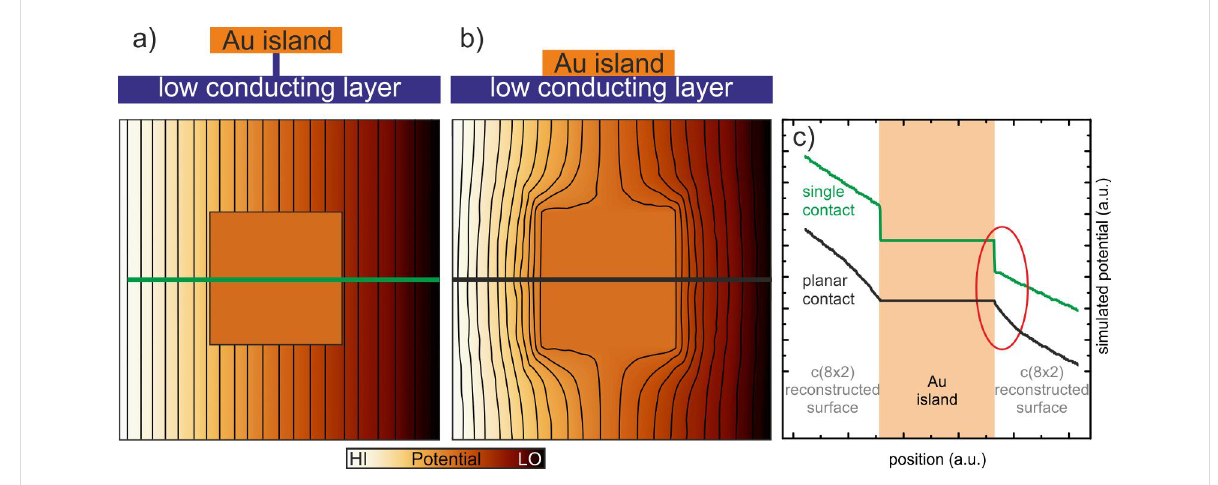
Figure 6: a) Finite elements simulation for the potential if one single path connects a highly conductive cluster to a low conducting substrate while the borders of the cluster are not connected to the substrate (single point contact). b) Simulated potential if the highly conductive cluster is placed directly on top of a low conducting substrate (planar contact). The colour palette represents the potential variation. As a guide to the eye equipotential lines are superimposed. A side view of the corresponding contact geometry is shown above each simulation. c) Line profiles for both contact geometries